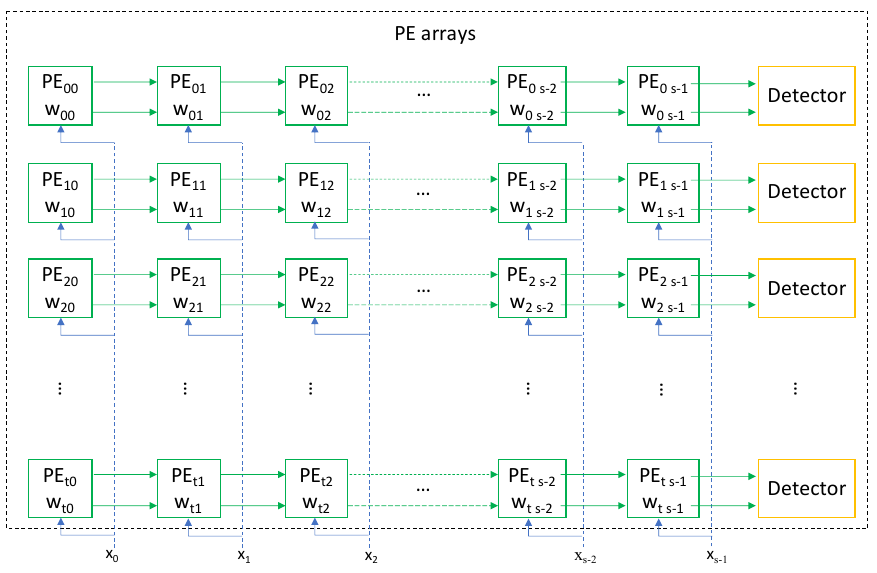
Figure 5. Convolutional layer parallel PE arrays based on time domain.